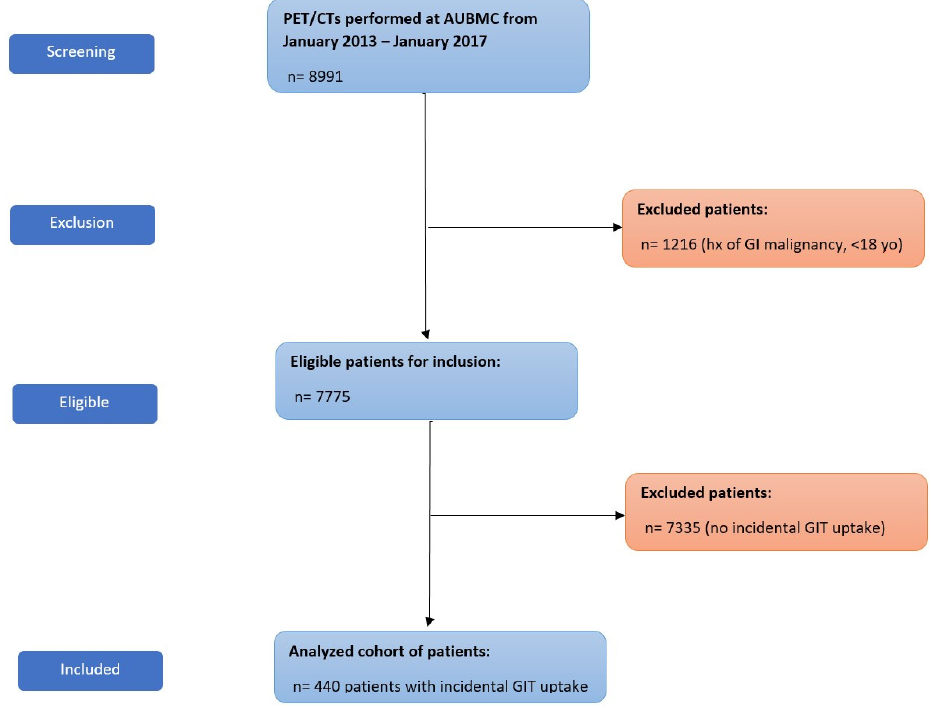
Figure 1. Flow diagram of patient recruitment. Abbreviations: hx, history; GI, gastrointestinal; yo, years-old.